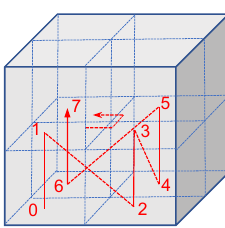
Figure 5. The corresponding coding order of child space–time